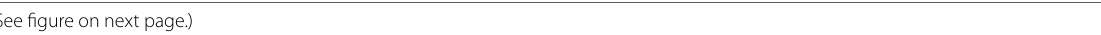
Table 1 Area, representative thickness, and estimated volume of the October 2014 rain‑triggered lahar deposits Cohesive debris flow with boulders (from the Aka- gawa to the confluence of the Denjogawa River) Mud slurry facies (from the Akagawa/Denjogawa Rivers confluence to the Otaki